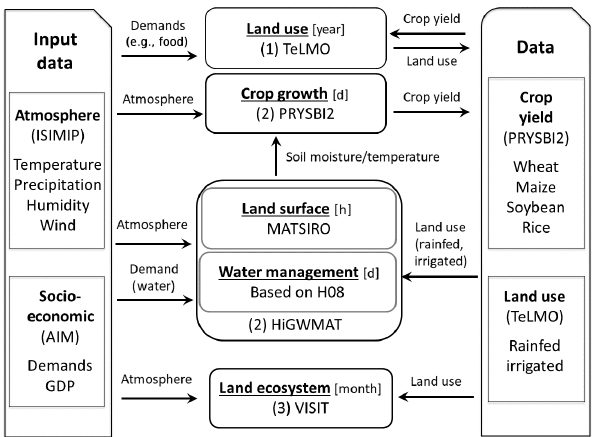
Figure 2. The numerical simulation procedure in MIROC-INTEG- LAND. The order of the numerical integration is (1) TeLMO, (2) HiGWMAT + PRYSIB2, and (3) VISIT as described in Sect. 4. Boxes indicate the submodels and data. For the submodels, the name and time step of the models are indicated in the boxes. In the “Data” box, the name of the variable saved as a file is indicated. In the “Input data” box, information regarding the input data is in-